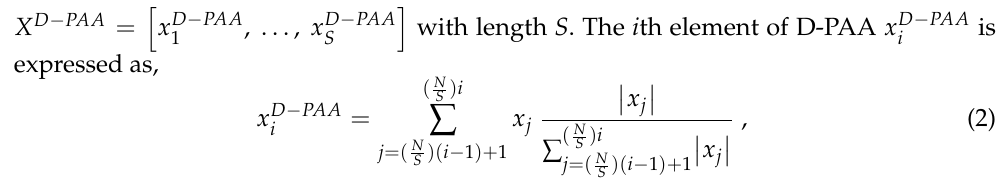
where i ranges from 1 to S , x j is the j th element of X , and j th element of X .